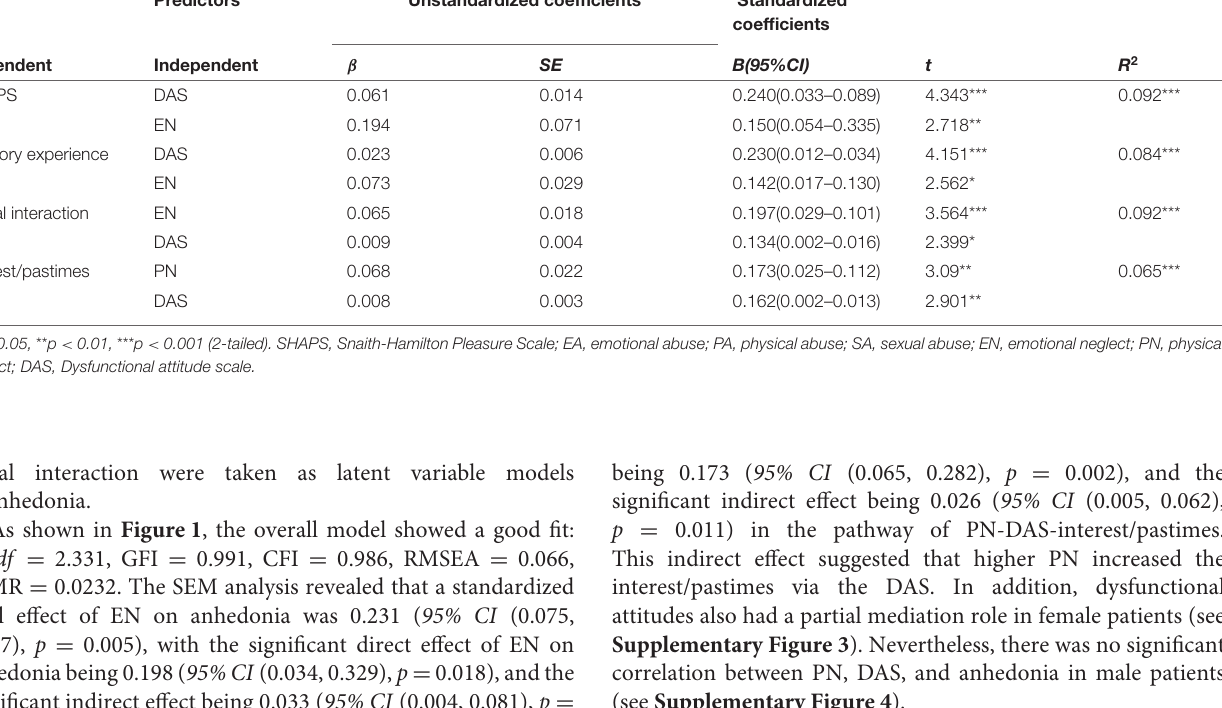
TABLE 4 | Stepwise multiple linear regressions analyses: associations of childhood traumas and dysfunctional attitudes with anhedonia.